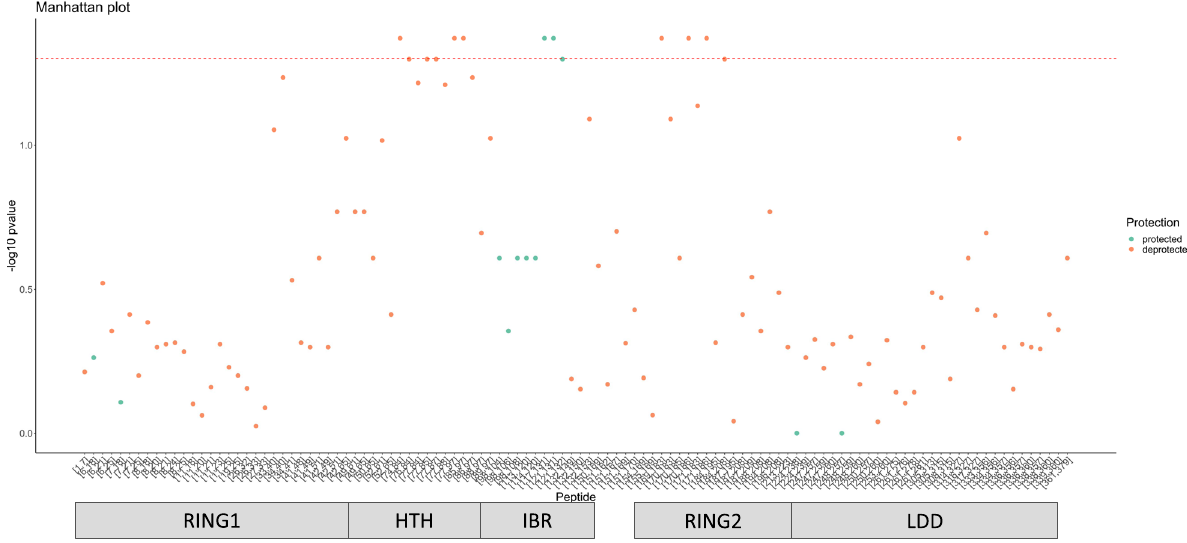
Fig. 6 Manhattan plots provide spatial context of deuterium chances for HOIP-RBR-dAb25. A Manhattan plot with peptides described as the amino acid (AA) segments of the protein sequence plotted against the (cid:1) log 10 ð p -value Þ . Protein domain annotations are provided in the bar below 26 . The red dashed line indicates a signi fi cance threshold (cid:1) log 10 ð 0 : 05 Þ and p -values have been corrected for multiple testing.